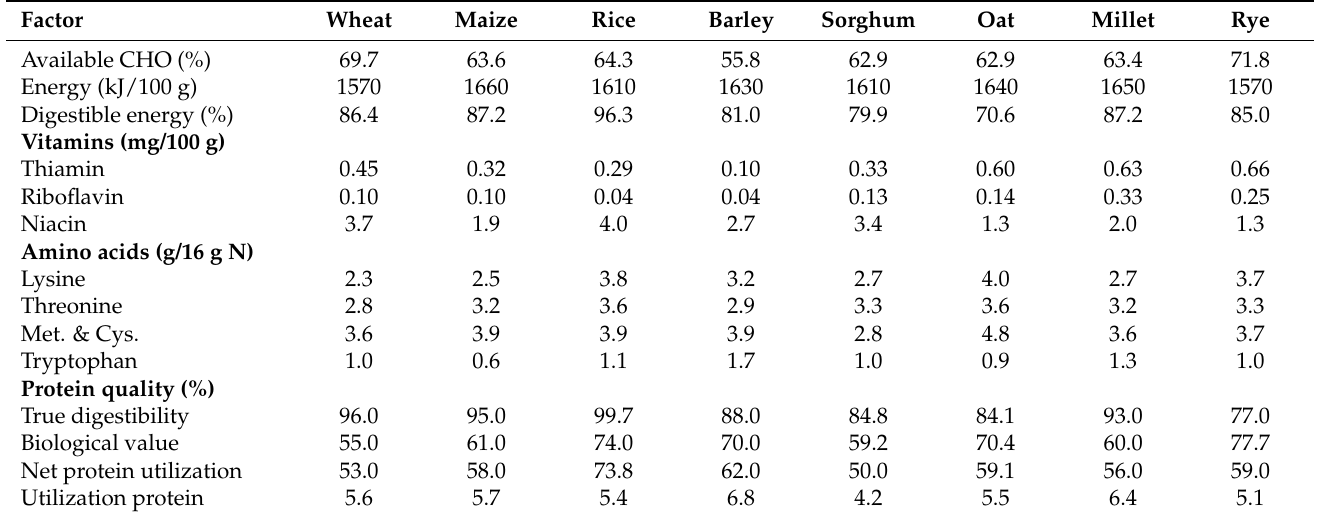
Table 1. Comparative nutritive value of cereal